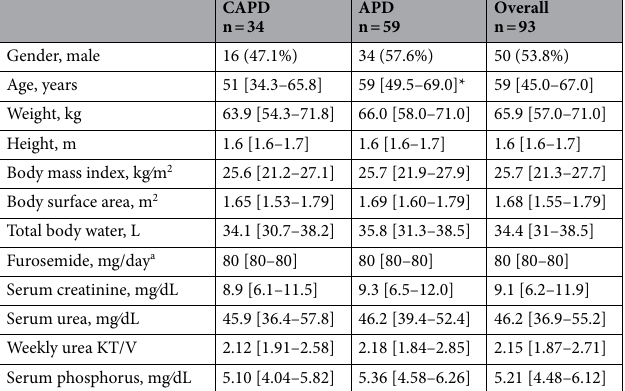
Table 1. Demographic and laboratory characteristics of non-anuric patients on continuous ambulatory (CAPD), automated peritoneal dialysis (APD) and for pooled data. *Statistical difference versus CAPD at p < 0.05. a See “Methods” for further information on the distribution of furosemide doses.